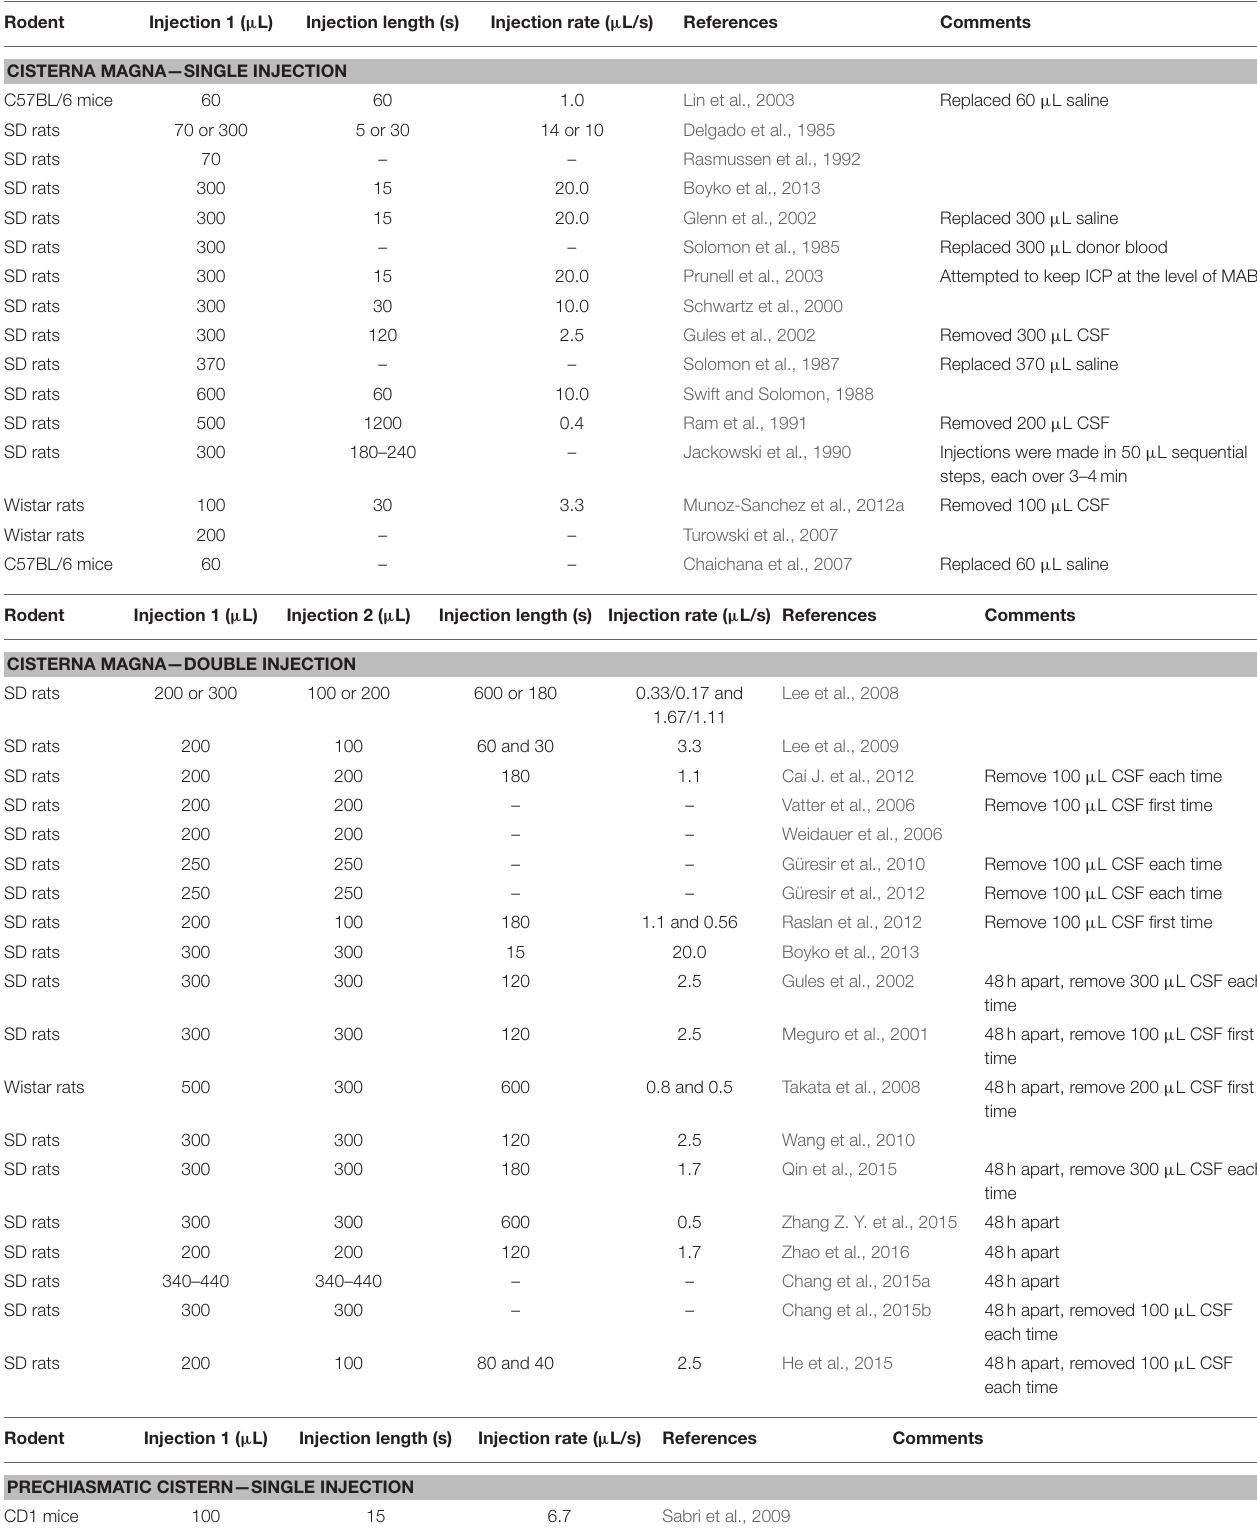
TABLE 1 | Summary of single- and double-injection cisterna magna models and single-injection prechiasmatic cistern models in published studies that used various strains of mice or rats. Rodent